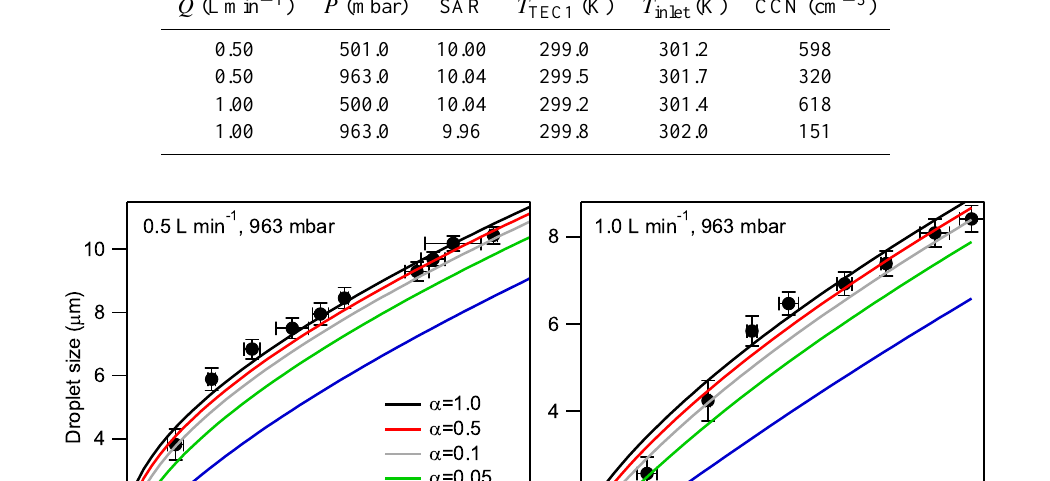
Table 1. Average flow rate ( Q ), pressure ( P ), sheath-to-aerosol flow ratio (SAR), TEC1 and inlet temperatures, and CCN concentrations at the instrument pressure and temperature for the four calibration experiments.